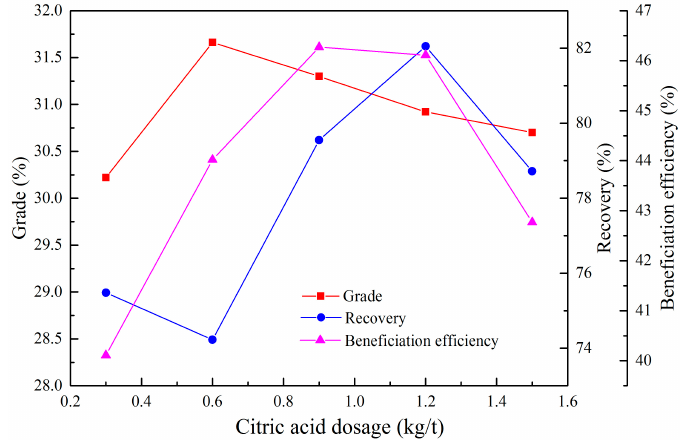
Figure 5. Effect of the citric acid dosage on the reverse flotation of the rougher concentrate.